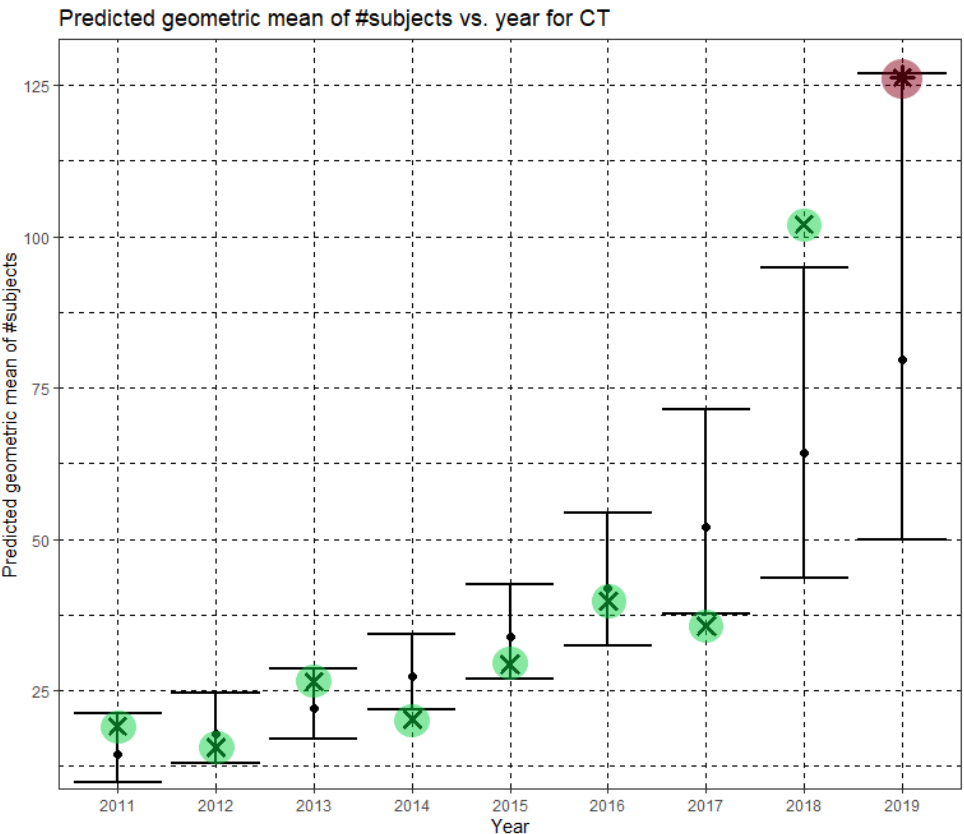
7 of 15 Figure 4. Phase I—Predicted geometric mean (black dots) and confidence intervals of dataset sizes in MICCAI articles involving MRI for the years 2011–2019, based on the whole ensemble of 2011– 2018 MRI dataset sizes. The empirical geometric means (2011–2018) are shown (in green) for com- parison (x marks). The empirical geometric mean for 2019 (in purple) became available later, in Phase II of this research. The regression model was statistically significant for CT as well, F(1,221) = 21.273, p < 0.001. The model explained 8.4% (adjusted R 2 ) of the variance in the natural logarithm of the dataset sizes. The year was statistically significant (B = 0.213, (CI = 0.122, 0.305), p <